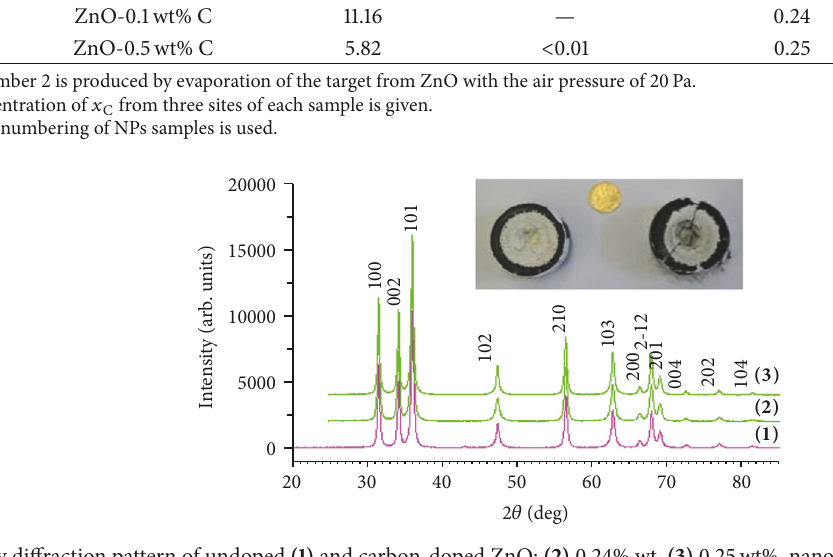
Figure 1: X-ray diffraction pattern of undoped (1) and carbon-doped ZnO: (2) 0.24% wt, (3) 0.25 wt%, nanopowders annealed at 773 K. On an insert, a photo of targets craters of samples number 3 and number 4 from Table 1; it is visible that color of the crater surface with high concentration of carbon is